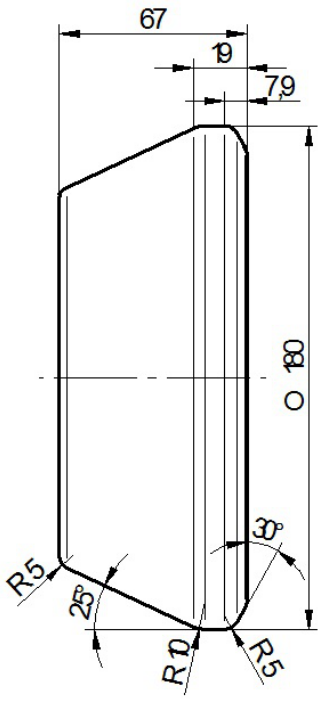
Figure 5: Geometrical dimensions of the forming roll.